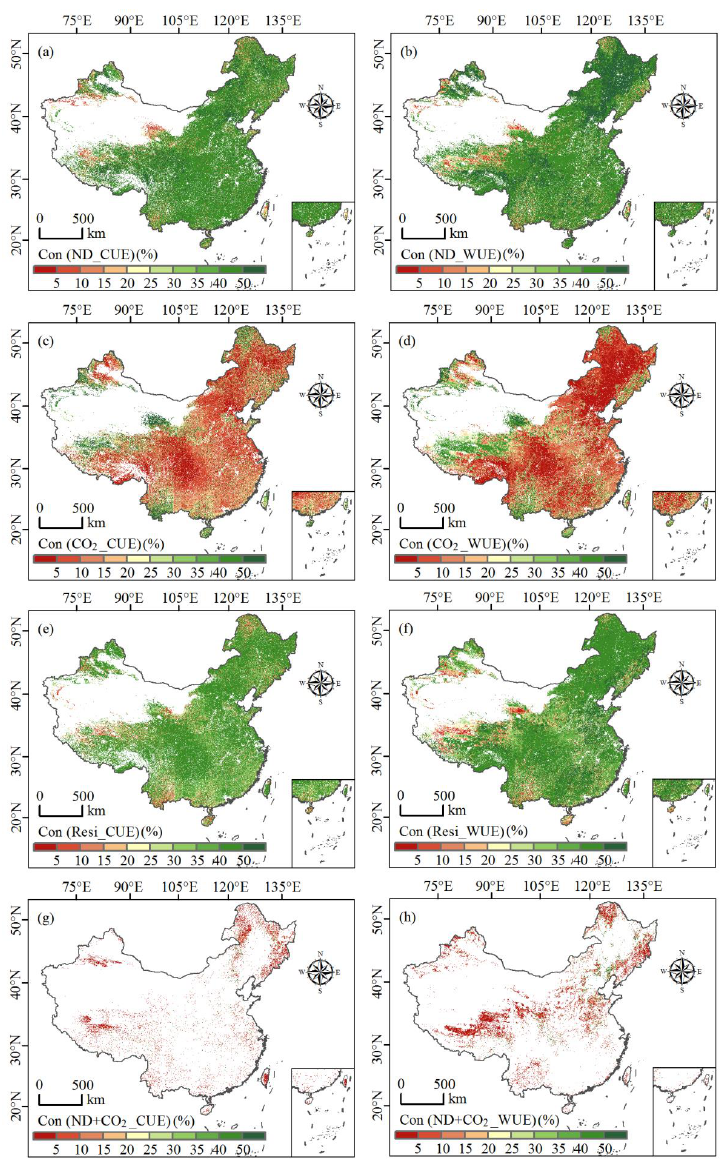
Figure 7. Contribution rates of ND, CO 2 , and residual factors to CUE and WUE. ( a , c , e ) Contribution of rates of ND, CO 2 , and residual factors to CUE, ( b , d , f ) Contribution of rates of ND, CO 2 , and residual factors to WUE, ( g ) ND enhances the contribution rate of CO 2 to CUE, ( h ) ND enhances the contribution rate of CO 2 to WUE.